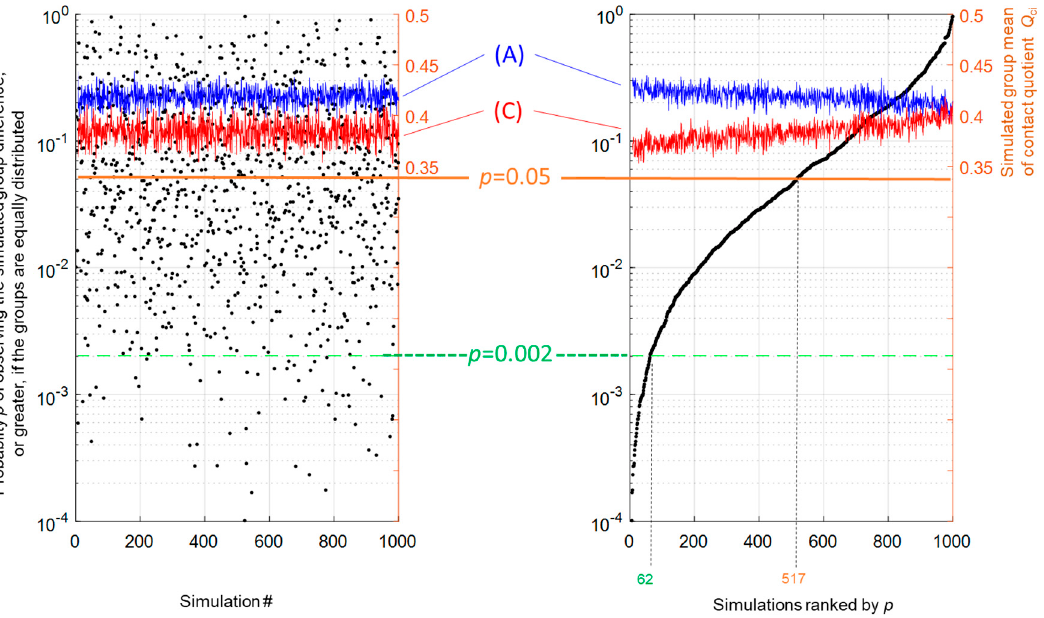
Figure 9. Left: Monte Carlo simulation of one thousand possible outcomes of randomly sampling two groups, of which the individual participant distributions are known, assuming normality (from Figure 8). To the right, the same data, but sorted by increasing p . On the left-hand vertical axis is the p value for the group difference observed for each draw; on the right-hand vertical axis are the sample averages (A) and (C) of groups A and C. The solid horizontal line indicates p = 0.05, while the dashed one indicates the p = 0.002 obtained when using the participant means instead of a random sample from each participant’s distribution.